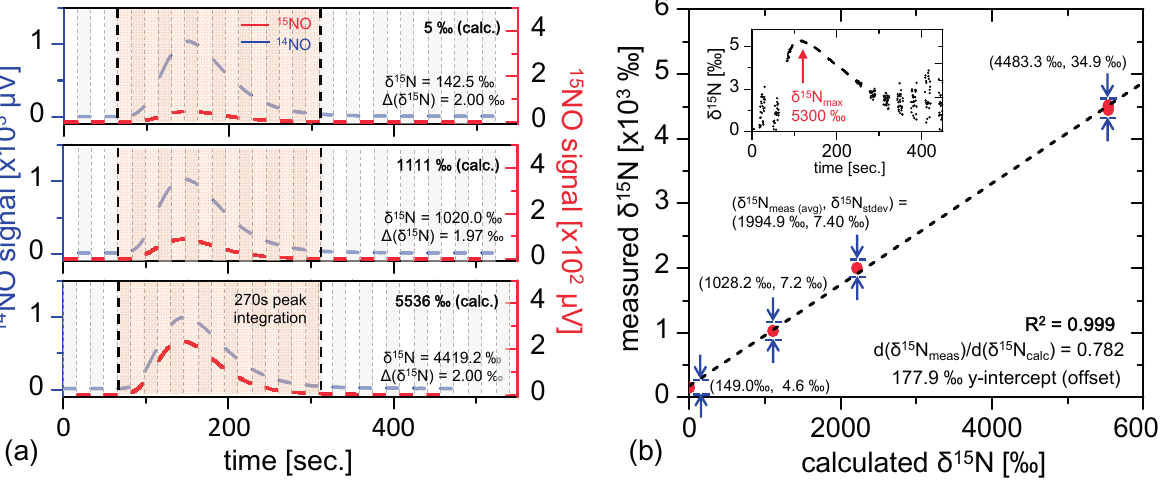
Figure 7. ( a ) Multiple injections of known isotopically labeled references spanning